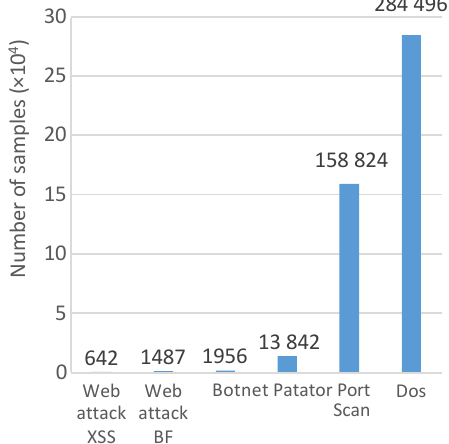
Fig. 11 Number of samples for different intrusive attacks in the CICIDS2017 dataset.